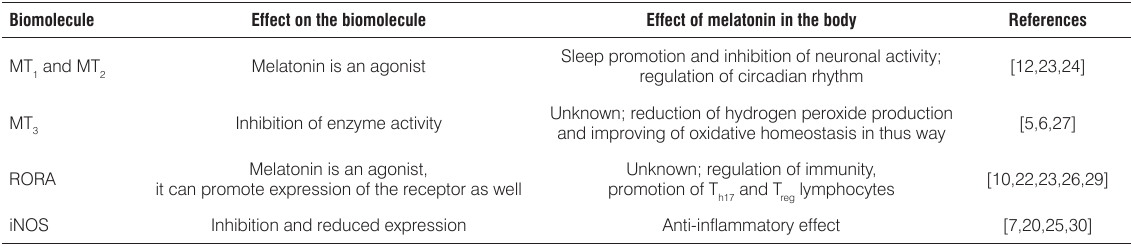
Table 1. Summarization of chosen targets for